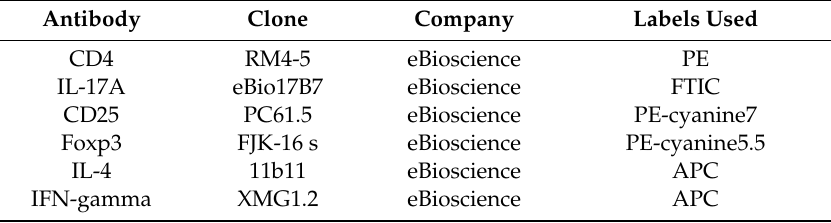
Table 2. Antibodies used for flow